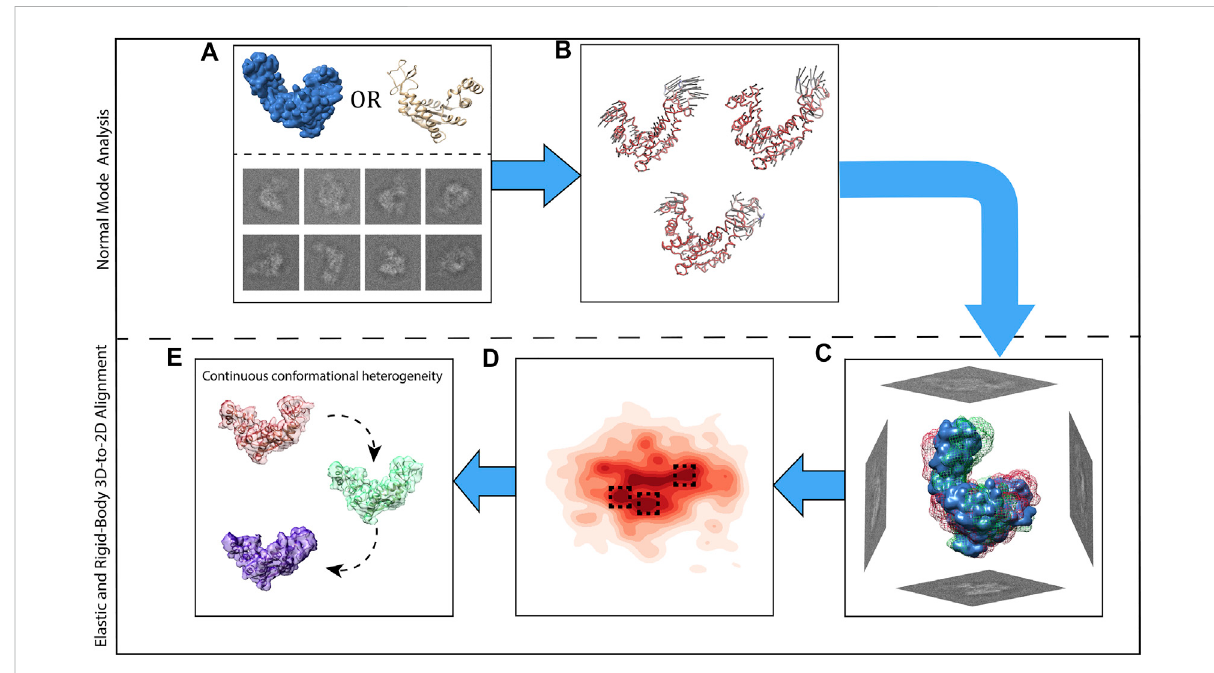
FIGURE 2 Graphical summary of HEMNMA steps. (A) Input EM map or atomic structure (the reference) and input single particle images. (B) Normal mode analysis of the reference and selection of normal modes (vectors). (C) Elastic and rigid-body alignment of each single particle image with the reference usingtheselectednormal modes. (D) Mapping ofsingle particleimages ontoalow-dimensional (here,2D)conformationalspaceinwhich the reference can be animated (denser regions are marked with a darker red color; close points correspond to images with similar conformations and distant points to images with different conformations). (E) 3D reconstructions from the densest areas in the low-dimensional conformational space shown by squares in (D)